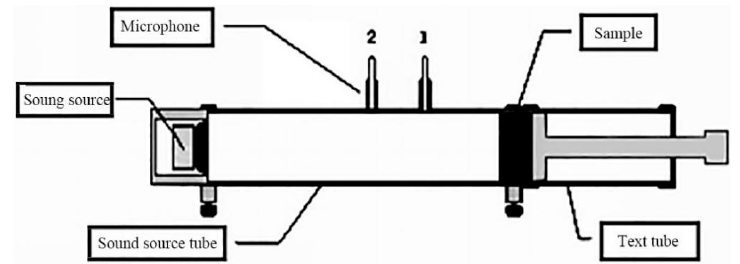
Figure 1. Schematic diagram of sound absorption test.